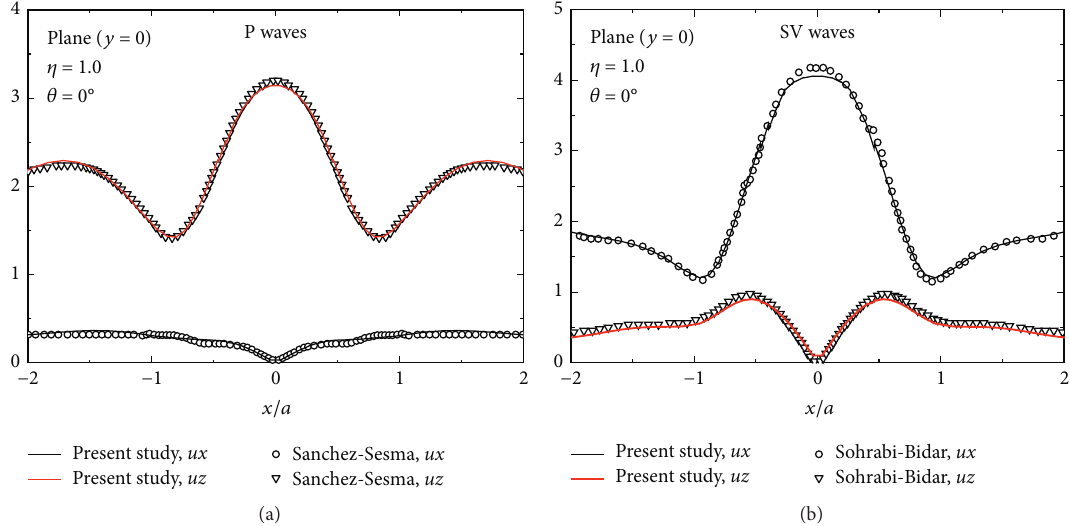
Figure 2: The surface displacement amplitudes of the present study compared with those of [40, 41]. (a) Incident P wave. (b) Incident SV